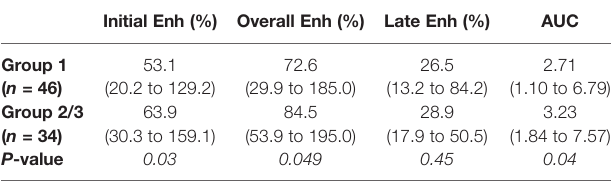
TABLE 2 | Top 10% BPE correlating with dichotomized Oncotype Dx score. Values are given as median